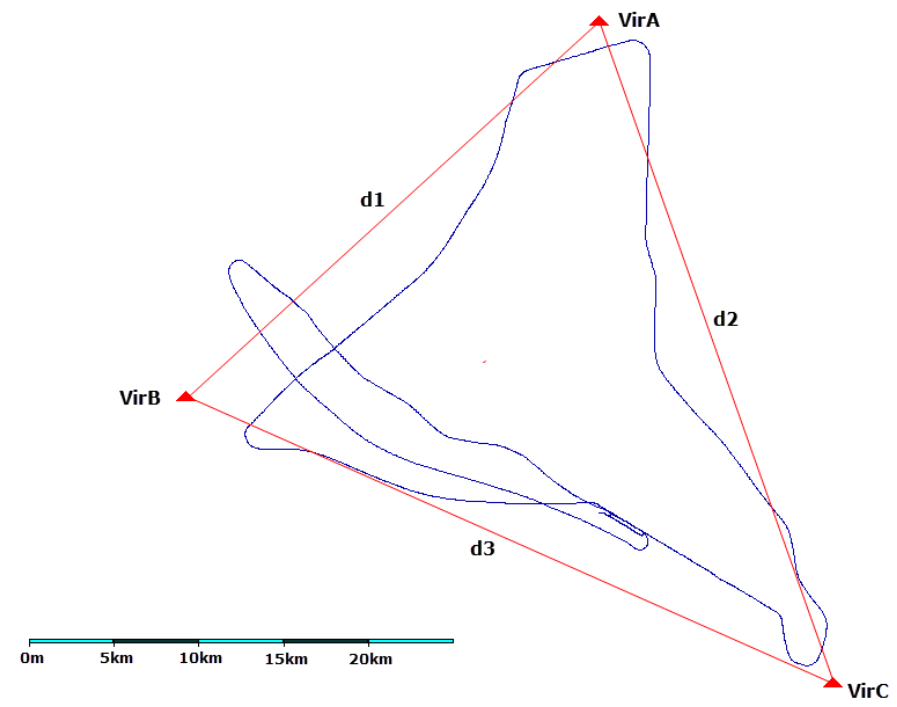
Figure 13. The horizontal trajectory of Cessna 172 aircraft with localisation of GNSS base stations. Similarly, to the results from the flight experiment in Mielec, the dispersion of position RTKPOST software was also used in the calculations to obtain results from the DGPS errors for the L component was the smallest for the flight test carried out in D˛eblin. On the other hand, the largest dispersion of position errors occurs for the h and RTK–OTF techniques. In addition, the algorithm scheme (Equations (6)–(16)) was made in Scilab software and the calculation results are shown in a graphical and tabular form.